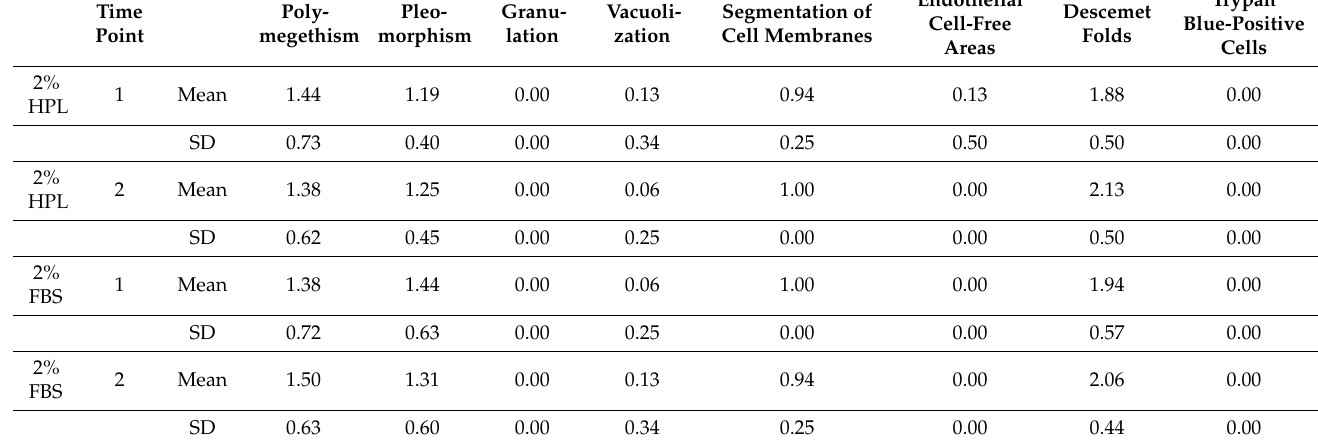
Table 3. Evaluation and scoring of endothelial cell layer alterations after 3 days of organ culture in 2% HPL containing medium (2%HPL; time point 2) using phase contrast